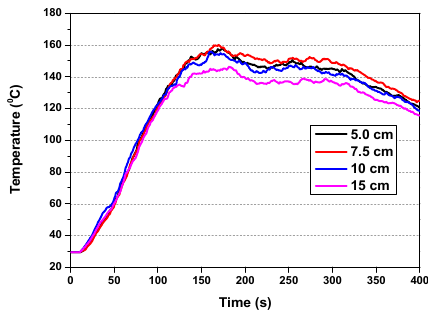
Figure 5. Ceiling temperature at point 1 with different grid size without sprinkler activation.